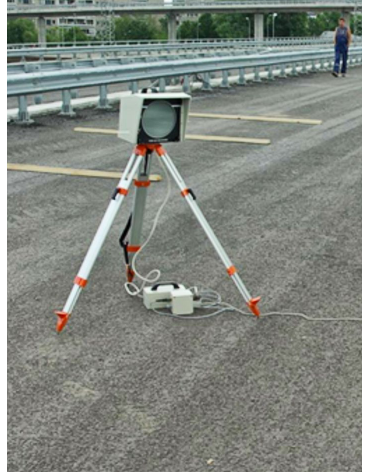
Fig. 1. The vibration sensor Noptel